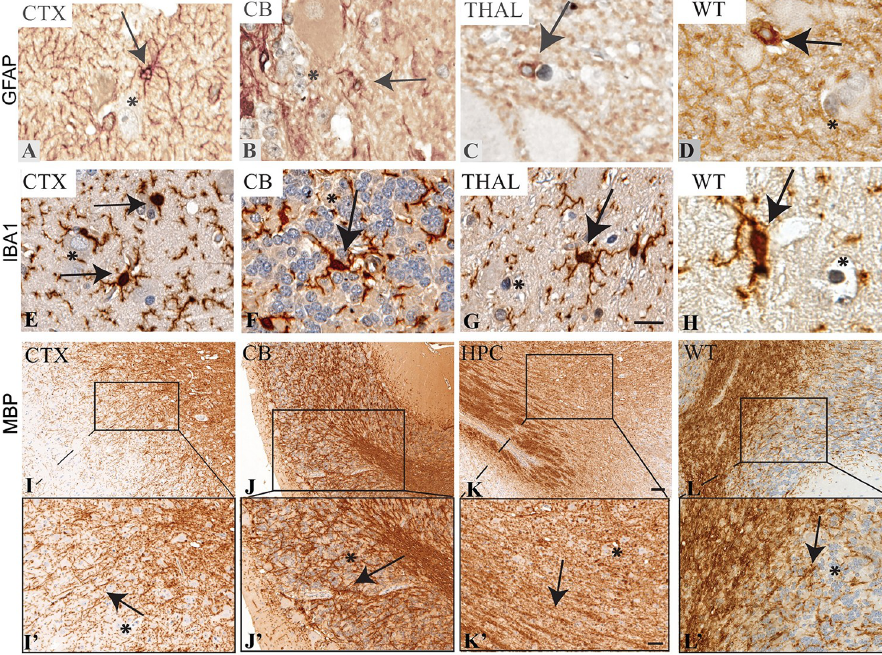
Fig 1. Immunolabeling of known markers in various regions of NF1 mutant miniswine brain. Brain regions are identified as cortex (CTX), cerebellum (CB), thalamus (THAL), and hippocampus (HPC). A-D: GFAP+ expression in the cortex, cerebellum, and thalamus, localized to the membrane and filaments of astroyctes. Arrows indicate classic, star-shaped morphology of astrocytes. E-H: Iba1+ expression in the cortex, cerebellum, and thalamus, localized to the cytoplasm of microglia. Arrows indicate both ramified and ameboid-like microglia. Scale bar: 50 μ m. I-L: MBP + expression in the cortex, cerebellum, and hippocampus, localized to the membrane and cytoplasm of mature oligodendrocytes. Scale bar: 500 μ m. I’-L’: Enhanced magnification of panels I-L. Scale bar: 200 μ m. Asterisks indicate lack of immunolabeling in neurons, as expected.